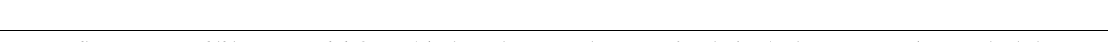
Figure 2 | asb2b mutant cardiomyocytes exhibit structural defects. ( a ) Three-dimensional images of 50 hpf Tg(myl7:LIFEACT - GFP) WTand asb2b mutant hearts reveal differences in myofilament thickness and organization. Magnified views of myofilaments in white boxes are shown on the right. Myofilament thickness was measured in 50 hpf WT and asb2b mutant hearts ( n ¼ 29 myofilaments from 5 hearts). ( b ) Three-dimensional images of 50 hpf Tg(myl7:LIFEACT-GFP);Tg(myl7:MKATE-CAAX) WT and asb2b mutant atria. The myofilaments in WT are organized across cell borders (arrows), whereas asb2b mutant hearts show disorganized myofilaments between adjacent cardiomyocytes (arrows). ( c ) Three-dimensional images of 50 hpf Tg(myl7:actn3b - EGFP) WT and asb2b mutant atria. Atrial cardiomyocytes in WT exhibit an organized z -band pattern across cell–cell borders (arrows), whereas those in asb2b mutants exhibit a disorganized z -band pattern (arrows). ( d ) Three-dimensional images of 50 hpf Tg(myl7:ras-GFP) WTand asb2b mutant hearts. Magnified views of myofilaments in white dotted boxes are shown on the right. Cardiomyocytes are outlined to define shape. ( e ) Single- plane images of 50 hpf Tg(myl7:EGFP-Podocalyxin);Tg(myl7:MKATE-CAAX) WT and asb2b mutant atria. In WT, EGFP-Podocalyxin is localized on the abluminal (apical) side of cardiomyocytes, whereas in asb2b mutants, it appears to be localized on both the abluminal and luminal (basal) sides (arrows). Number of cardiomyocytes exhibiting EGFP-Podocalyxin localization on the basal side in WTand asb2b mutant hearts ( n ¼ 5 hearts, with averages taken from 20 cells per heart). * P o 0.05 and ** P o 0.01 by one-way analysis of variance (ANOVA) followed by Tukey’s honest significant difference test. Error bars, s.e.m. Scale bars, 20 m m. At, atrium; V, ventricle. NATURE COMMUNICATIONS|8:14495|DOI: